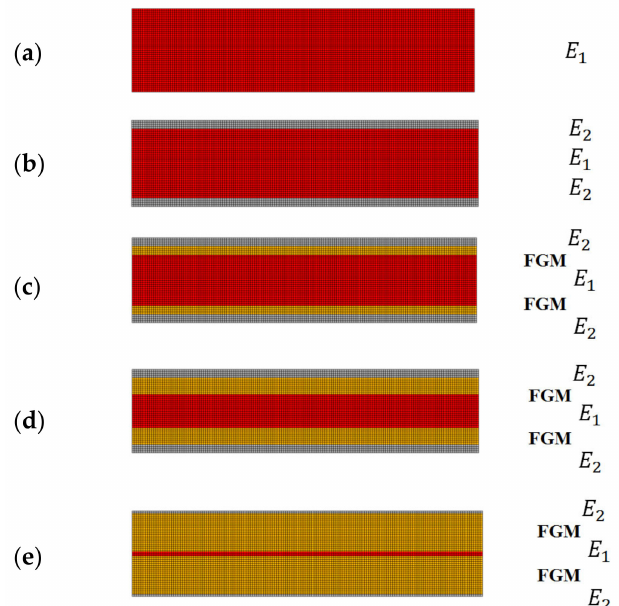
Figure 12. The materials distribution for initial rectangular structure: ( a ) one material structure; ( b ) two materials structure: E 1 —red color, E 2 —gray color, E 1 < E 2 ; ( c ) two materials structure: E 1 —red color, E 2 —gray color, E 1 < E 2 including 4 layers of FGM interface—yellow color; ( d ) two materials structure: E 1 —red color, E 2 —gray color, E 1 < E 2 including 8 layers of FGM interface—yellow color; ( e ) FGM structure: E 1 —red color, E 2 —gray color, FGM—yellow color.